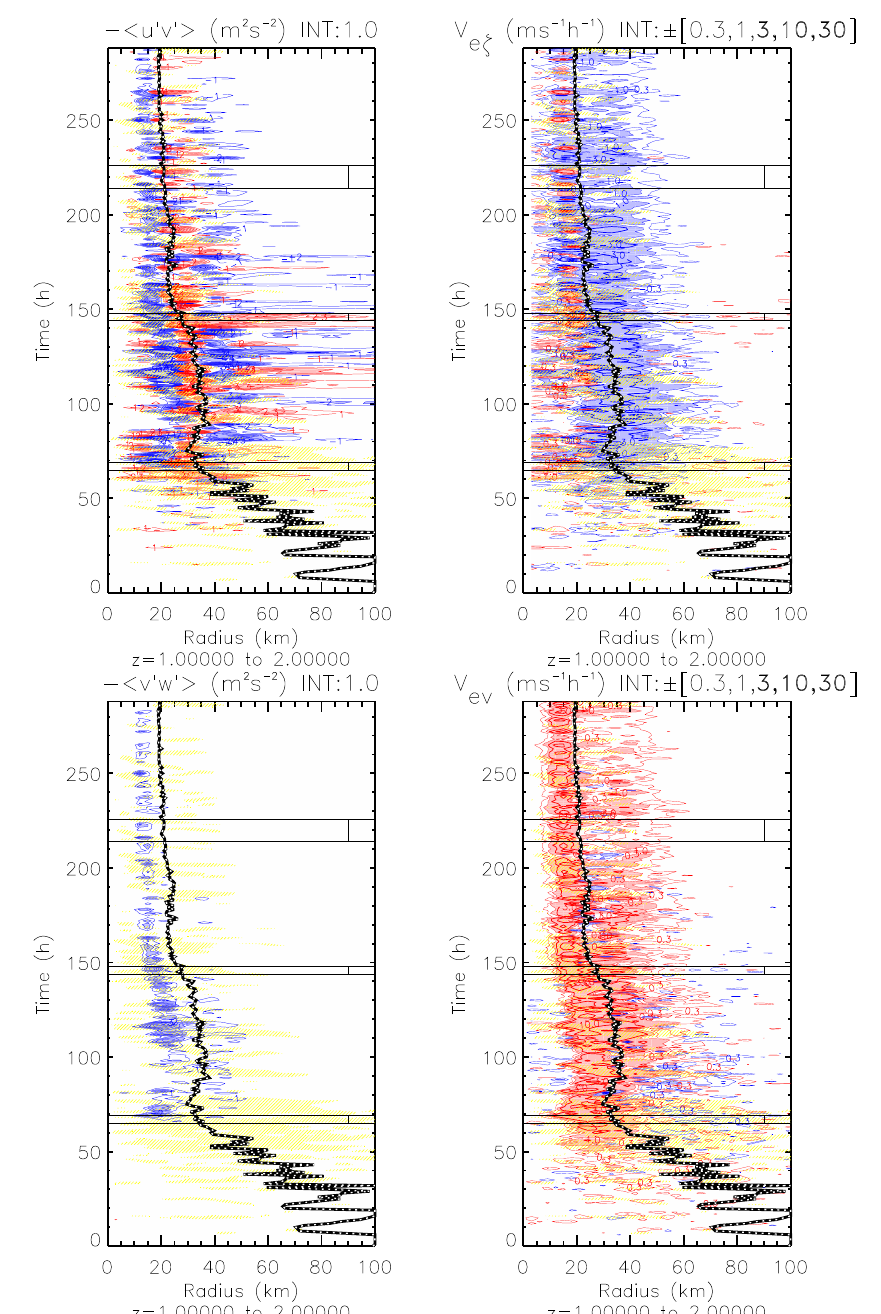
Fig. 19. Radius-time (Hovm¨oller) plots of layer-averaged (a) horizontal eddy momentum flux ( −h u ′ v ′ i ), (b) radial eddy vorticity flux ( V eζ ), (c) vertical eddy tangential momentum flux ( −h w ′ v ′ i ) and (d) vertical advection of eddy tangential momentum ( V ev ), averaged between 1 and 2km altitude from the 3D3k simulation. (a) Contour interval ± 1.0m 2 s − 2 ; (b) contours, ± 0.3, 1, 3, 10 and 30ms − 1 h − 1 ; (c) contour interval ± 1.0m 2 s − 2 ; (d) contours ± 0.3, 1, 3, 10 and 30 m s − 1 h − 1 . Red contours denote positive values and blue contours denote negative values. Spotted black-curve denotes layer-averaged RMW. Yellow shaded area denotes regions where the layer-averaged tangential wind tendency is positive and exceeds 0.25ms − 1 h − 1 . Horizontal black lines denote the time intervals analysed in detail in this paper.